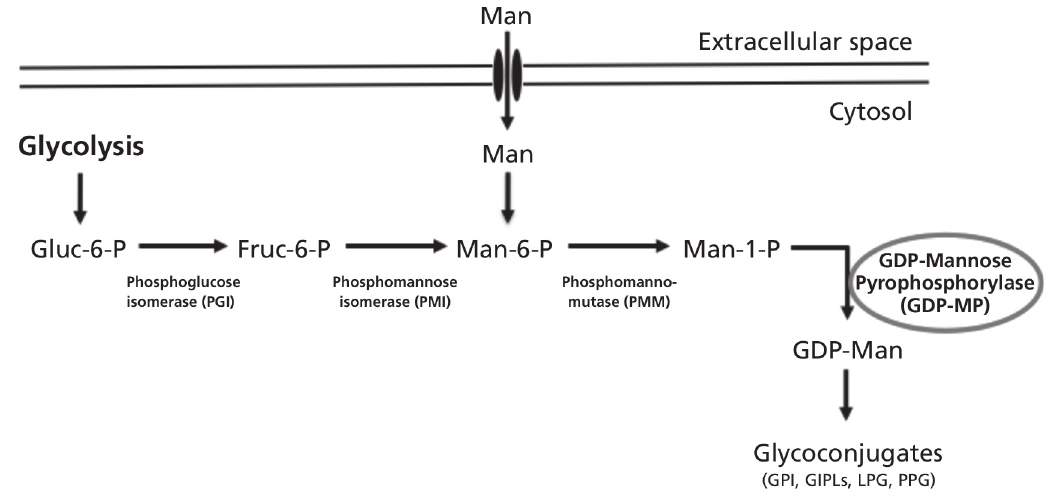
Fig. 1. – Mannose activation pathways and glycoconjugate biosynthesis in Leishmania . This pathway is used to synthesize various glycoconjugates: GPI (glycophosphatidylinositol) anchors, GIPLs (glycosylinositolphospholipids), LPG (lipophosphoglycans) or PPG (proteophosphoglycans). The GDP-MP enzyme is circled in